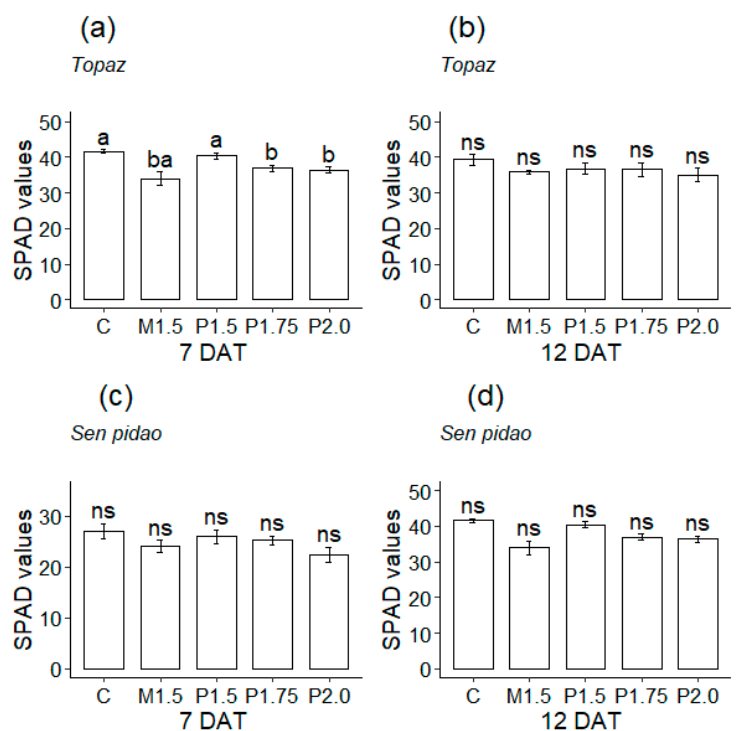
Figure 4. SPAD or leaf greenness as affected by pendimethalin rates as P 1.5, 1.75, 2.0 kg a.i. ha − 1 and C as the untreated control and M 1.5 as control 2 with 1.5 kg a.i. ha − 1 S -metolachlor herbicide for Topaz variety at 7 DAT ( a , b ) and Sen pidao variety at 12 DAT ( c , d ). ‘ns’ represents not significant, while means of the same letters are not significantly different at p < 0.05; error bars represent the standard error.